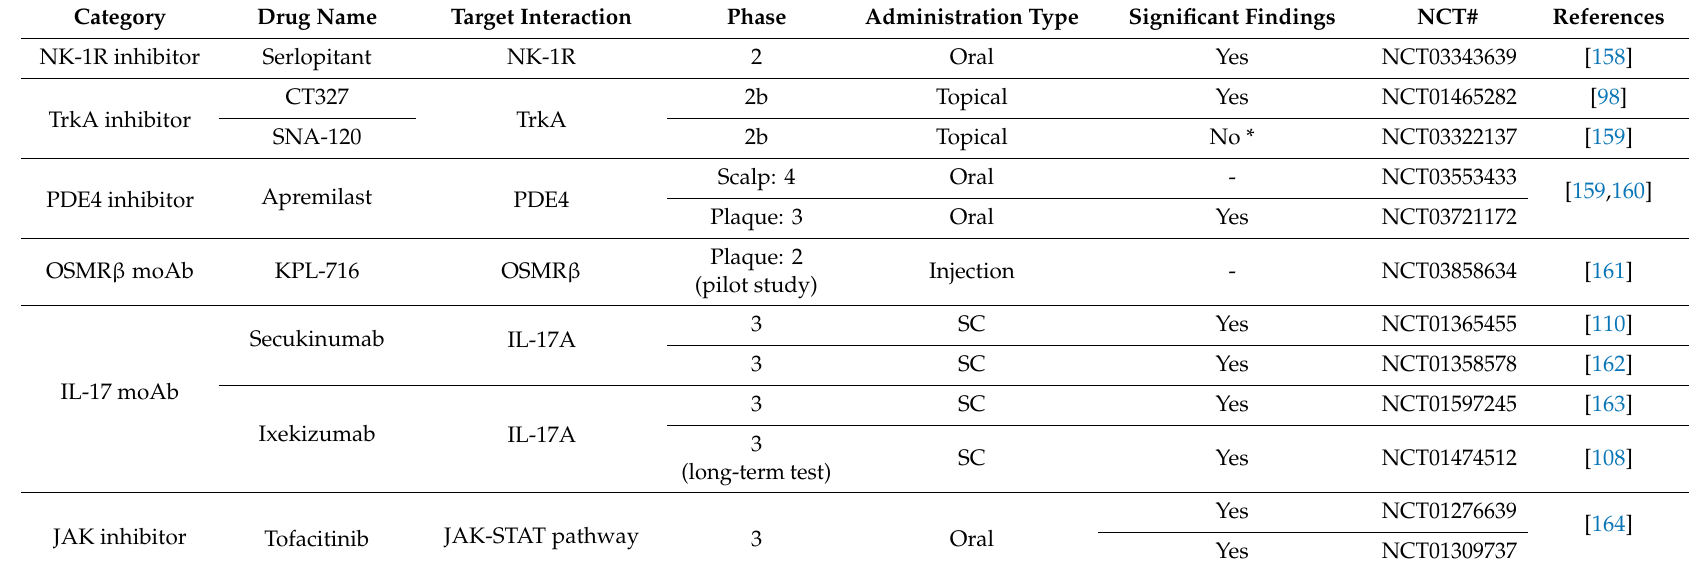
Table 2. Candidates for psoriatic antipruritics in clinical